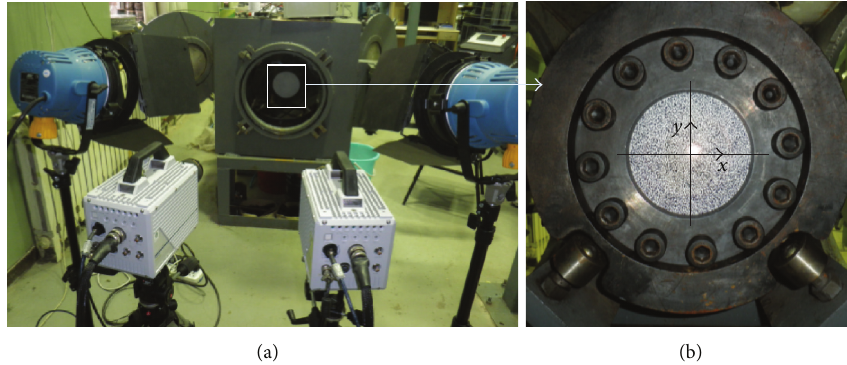
Figure 4: Photos of the experimental setup: (a) global view of 3D DIC measurement system with two high-speed digital cameras mounted in a stereo configuration and two light spots based on FSI experimental setup; (b) area of interest of the clamped test specimen painted with a black and white speckle